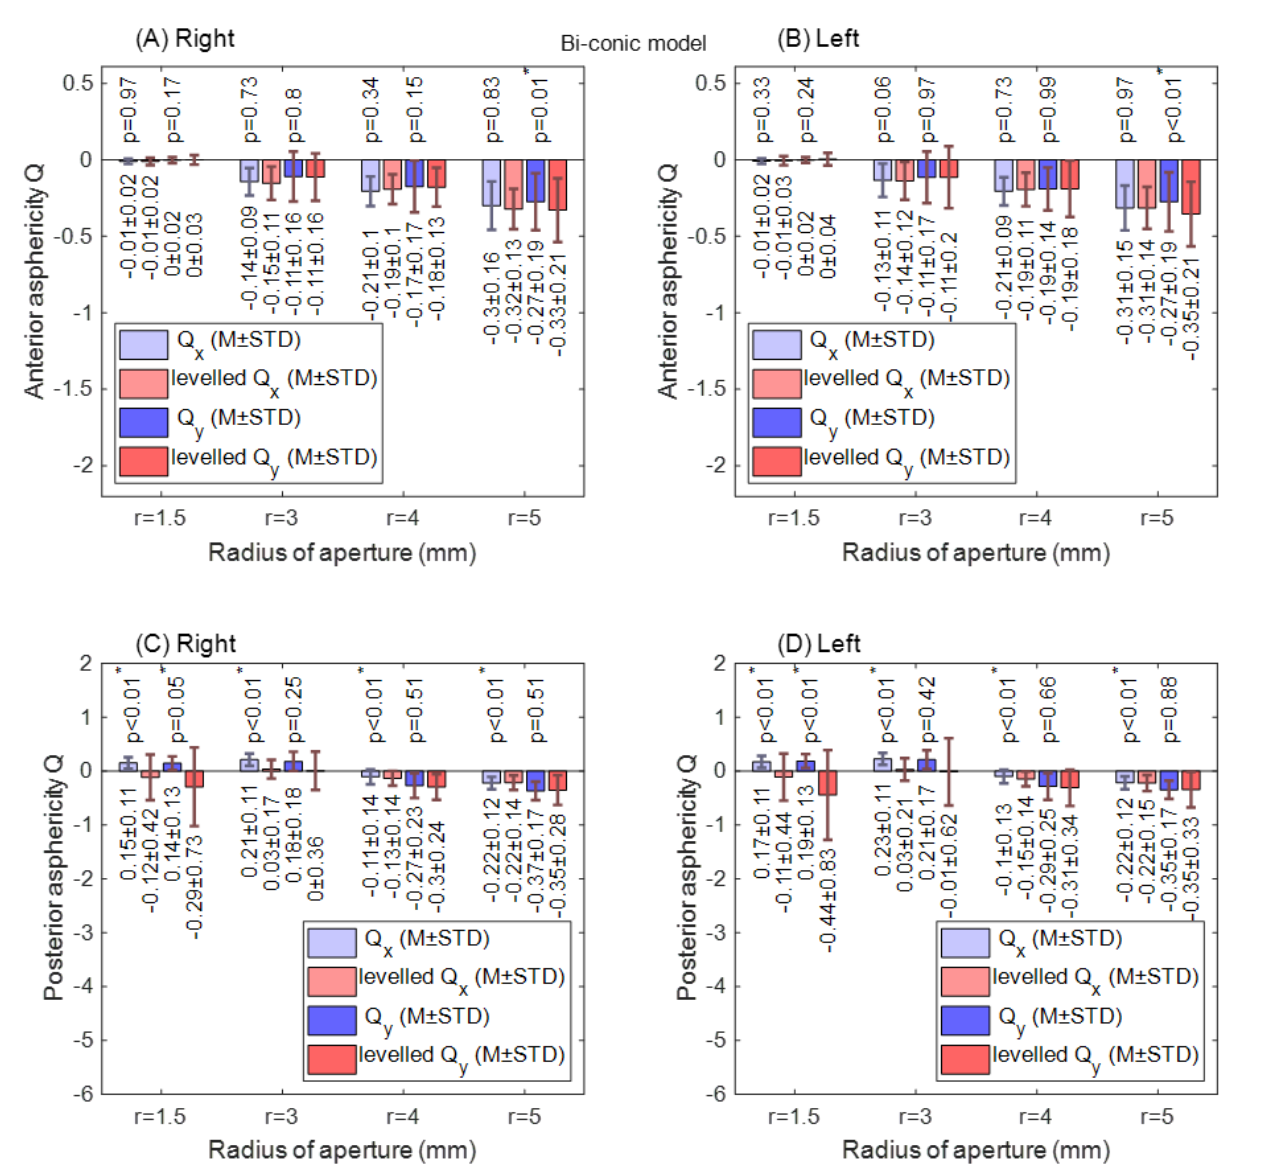
Figure 8. Corneal asphericity (Q) fitted to biconic model with different radii of aperture (r). The asterisk (*) indicates the statical significance. ( A )Anterior right corneal asphericities; ( B ) Anterior left corneal asphericities; ( C ) Posterior right corneal asphericities; ( D ) Posterior left corneal asphericities.